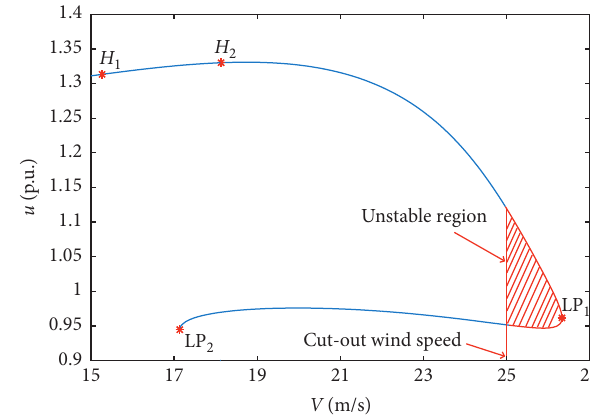
Figure 8: δ − u phase locus plot. 2